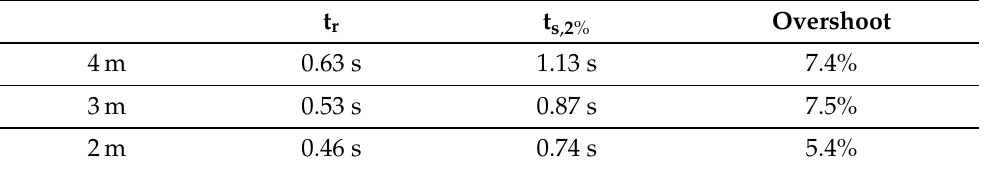
Figure 7. Comparison between the altitude and pitch dynamic for the non-linear MPC with different rise altitudes with constrained control surfaces. Table 5. Height overshoot for different altitudes for the MPC with constraints on control surfaces, rise.